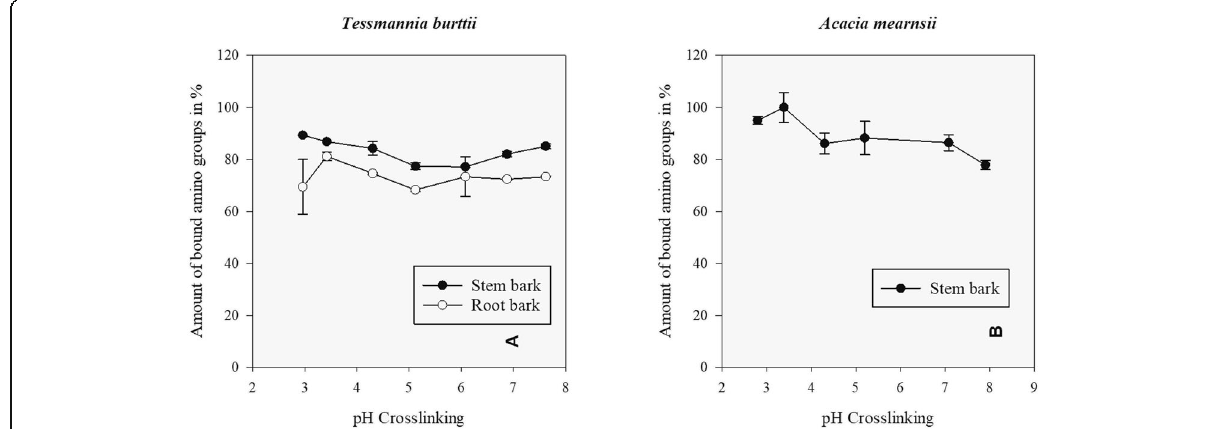
Fig. 3 Amount of bound amino-groups of hide powder cross-linked with the extracts of Tessmannia burttii ( a ) and Acacia mearnsii ( b ) extracted at 50 °C with pH dependence before acid